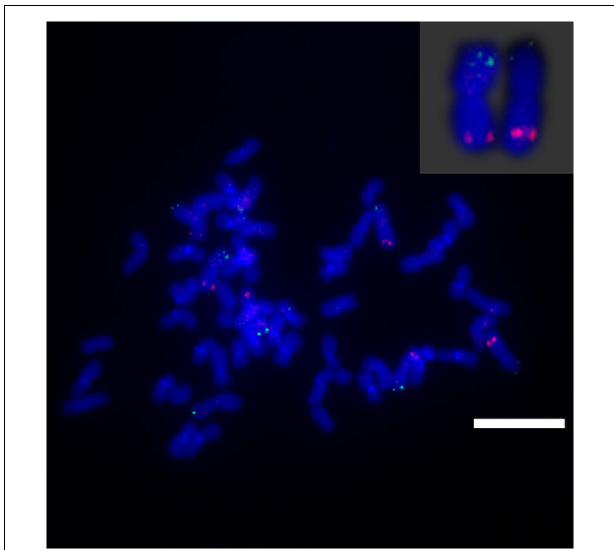
FIGURE 7 | The rearrangement of chromosome in sugarcane and sorghum as revealed by FISH. BAC-14 and BAC-19 probes labeled with biotin (green) and digoxigenin (red). Scale bars = 10 µ